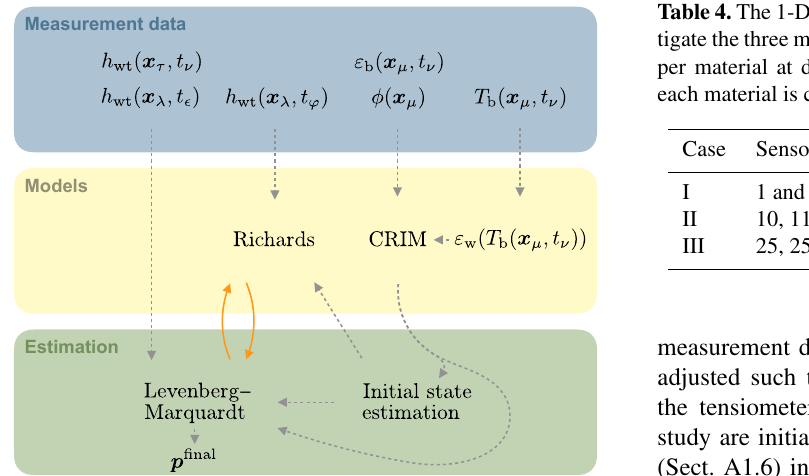
Figure 6. The available hydraulic potential h wt is measured at the bottom of the groundwater well x λ and at the position of the ten- siometer x τ . The data set, which is measured in the groundwater well, is split according to the measurement times: the data measured during the equilibration phases t (cid:15) enter the Levenberg–Marquardt algorithm (Sect. 2.3.1) directly, whereas the data measured during the forcing phases t ϕ are only used as a boundary condition for the Richards equation (Sect. 2.2.1). The bulk relative permittivity ε b ( x µ ,t ν ) and the bulk soil temperature T b ( x µ ,t ν ) are measured at the position of the TDR sensors x µ at times t ν . Additionally us- ing the porosity φ( x µ ) , the bulk permittivity is transferred to wa- ter content (Sect. 2.2.4). The water content data enter the initial state estimation (Sect. A1.6) yielding an initial water content dis- tribution and optional initial parameter values for the Levenberg– Marquardt algorithm. The water content data are also directly used in the Levenberg–Marquardt algorithm. Dashed grey arrows repre- sent one-time preparation steps, whereas solid orange arrows repre- sent the iterative steps of the Levenberg–Marquardt algorithm yield- ing the final material parameters p final .